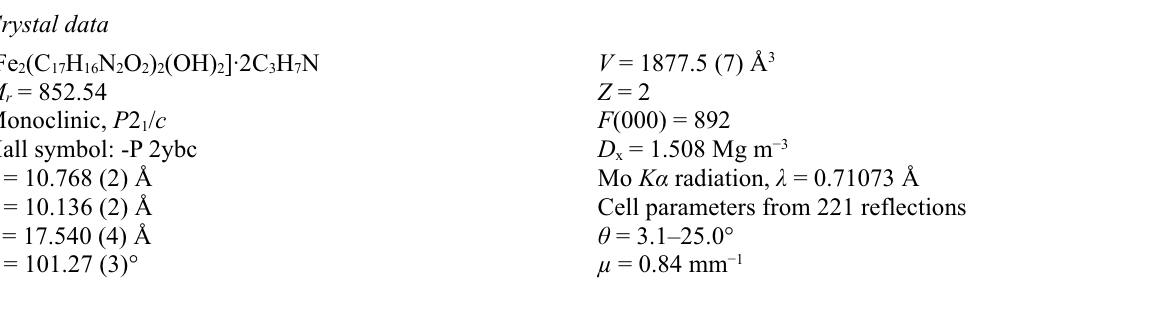
A view of (I) with the unique atom-labelling scheme. Displacement ellipsoids are drawn at the 30% probability level. Di- µ -hydroxido-bis({2,2 ′ -[propane-1,3- diylbis(nitrilomethylidyne)]diphenolato}iron(III)) dimethylformamide disolvate Crystal